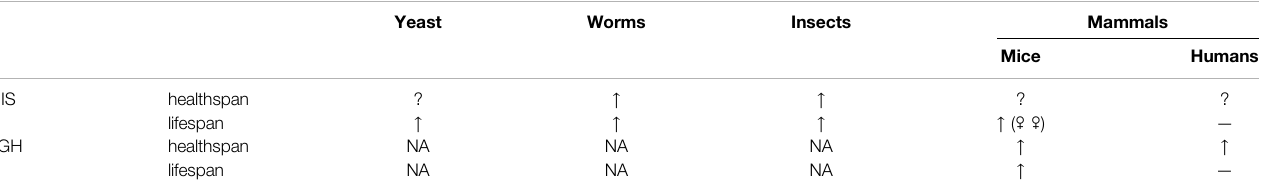
TABLE 1 | Effects of reduced IIS and GH signaling on healthspan and lifespan in different taxonomic